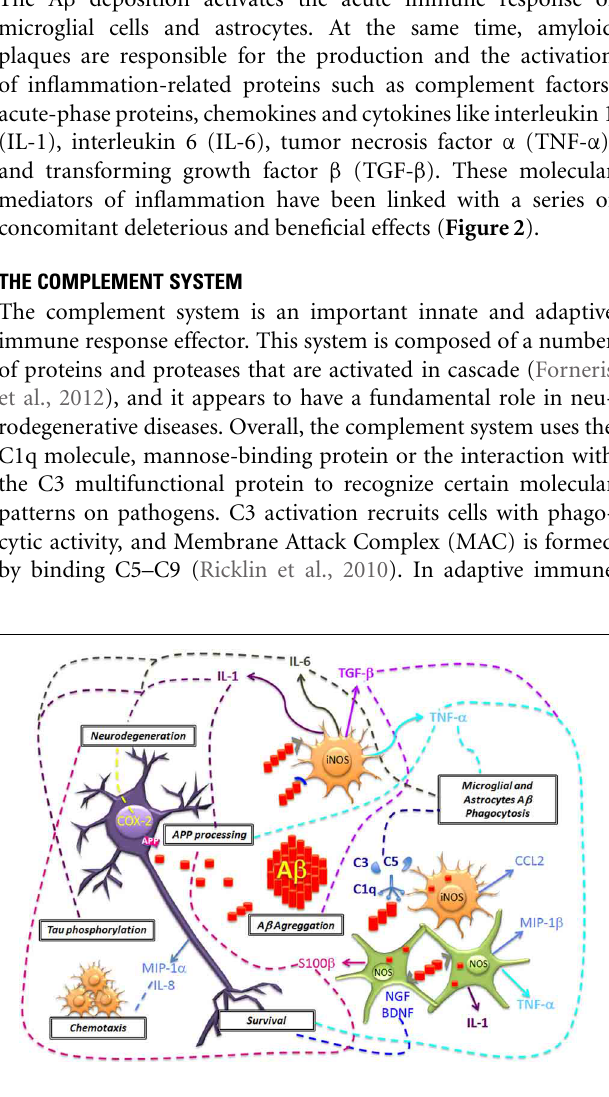
FIGURE 2 | Neuronal damage and A β deposition triggers microglial and astrocytes activation and the generation of inflammation molecular mediators. The acute production of molecules of the complement system (C1q, C3, and C5), pro-inflammatory cytokines (IL-1, IL-6, TNF- α ), chemokines (CCL2, MIP-1 α , MIP-1 β , and IL-8) mediate the A β clearance. However, in a chronic stage these molecules could promote an increased expression and alteration of APP processing, A β deposition, Tau phosphorylation and neurodegeneration. Also, another effect of glial cells includes the generation of NO that promotes oxidative stress. The inflammatory microenvironment favors the production of COX-2 in neurons that leads to apoptosis. In contrast, it has been proposed that glial cells could mediate neuronal survival, by the production of TGF- β and neurotrophic factors (BDNF and NGF), but the disease progression results in failure to repair